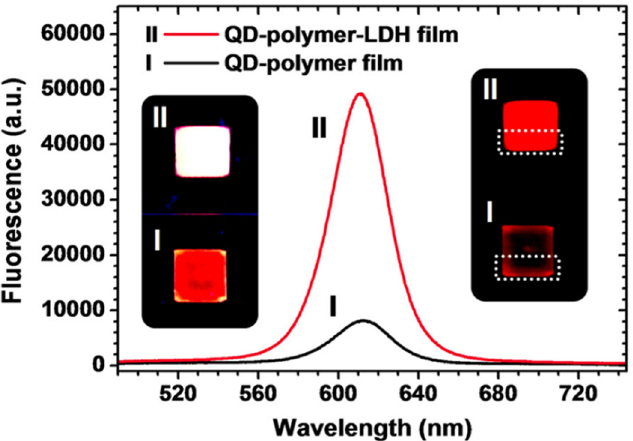
Figure 9. Photoluminescence spectra of films of (I) QD-polymer solution and (II) QD-polymer-LDH composite solution. (left inset) Photograph of the QD-polymer film and the (right inset) QD-polymer LDH composite film under 60 microW/cm 2 power UV light irradiation. Photograph of the films under lower power UV light irradiation for